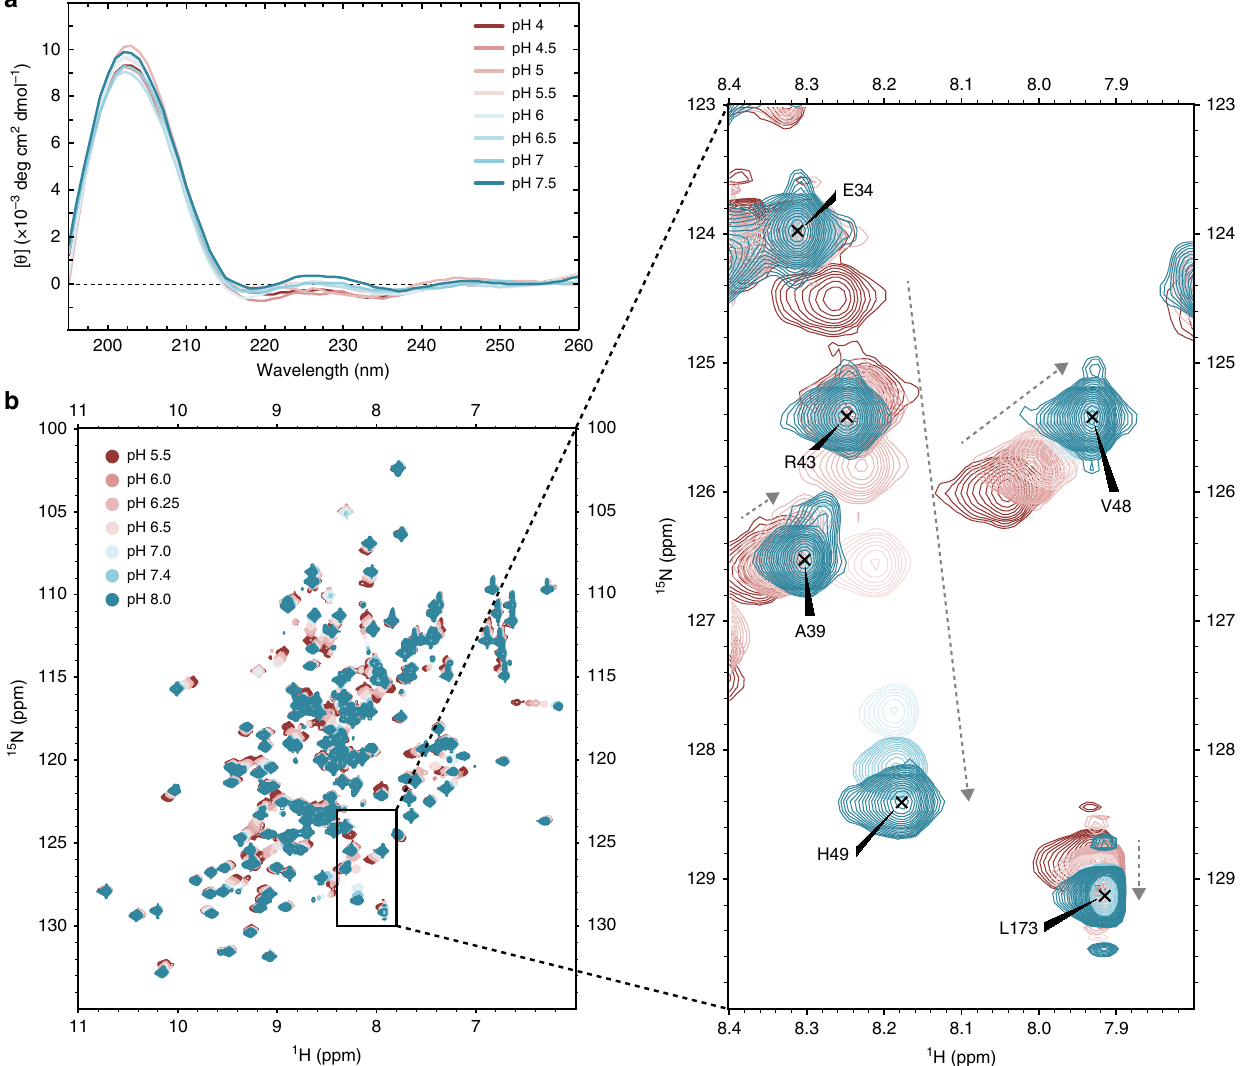
Fig. 2 Effects of pH on hMYDGF. a Smoothed CD spectra of hMYDGF in buffer ranging from pH 4.0 (maroon) to pH 7.5 (blue). Spectra were baseline subtracted from their corresponding buffer spectra. Source data for each spectra are provided as a Source Data fi le. b 1 H, 15 N HSQC spectra of hMYDGF in buffers ranging from pH 5.5 (maroon) to pH 8.0 (blue). Full spectra (left) and a representative expanded view (right) display a range of peak shifts from no movement (e.g., E34), to highly pH-sensitive peaks (e.g., H49). Arrows represent direction of peak perturbation as a result of increasing pH. Assignments shown are for peaks at pH